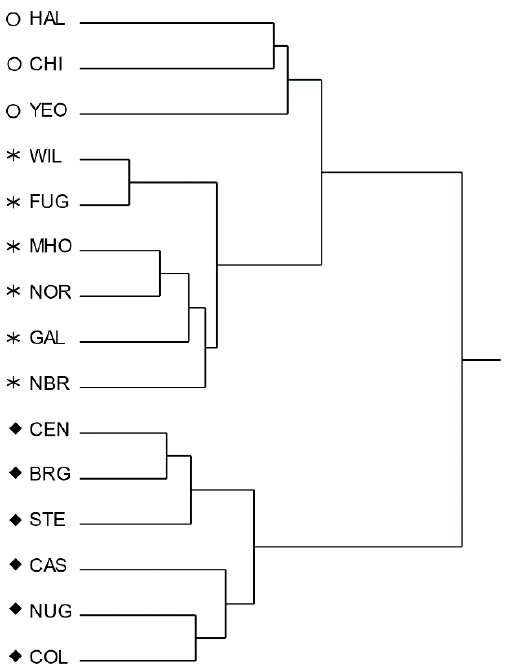
Figure 1. Dendrogram of the hierarchical cluster analysis among commercial varieties of H. lupulus L. cultivated in the Marche region, as determined by chemical similarity (Ward, distance scale).